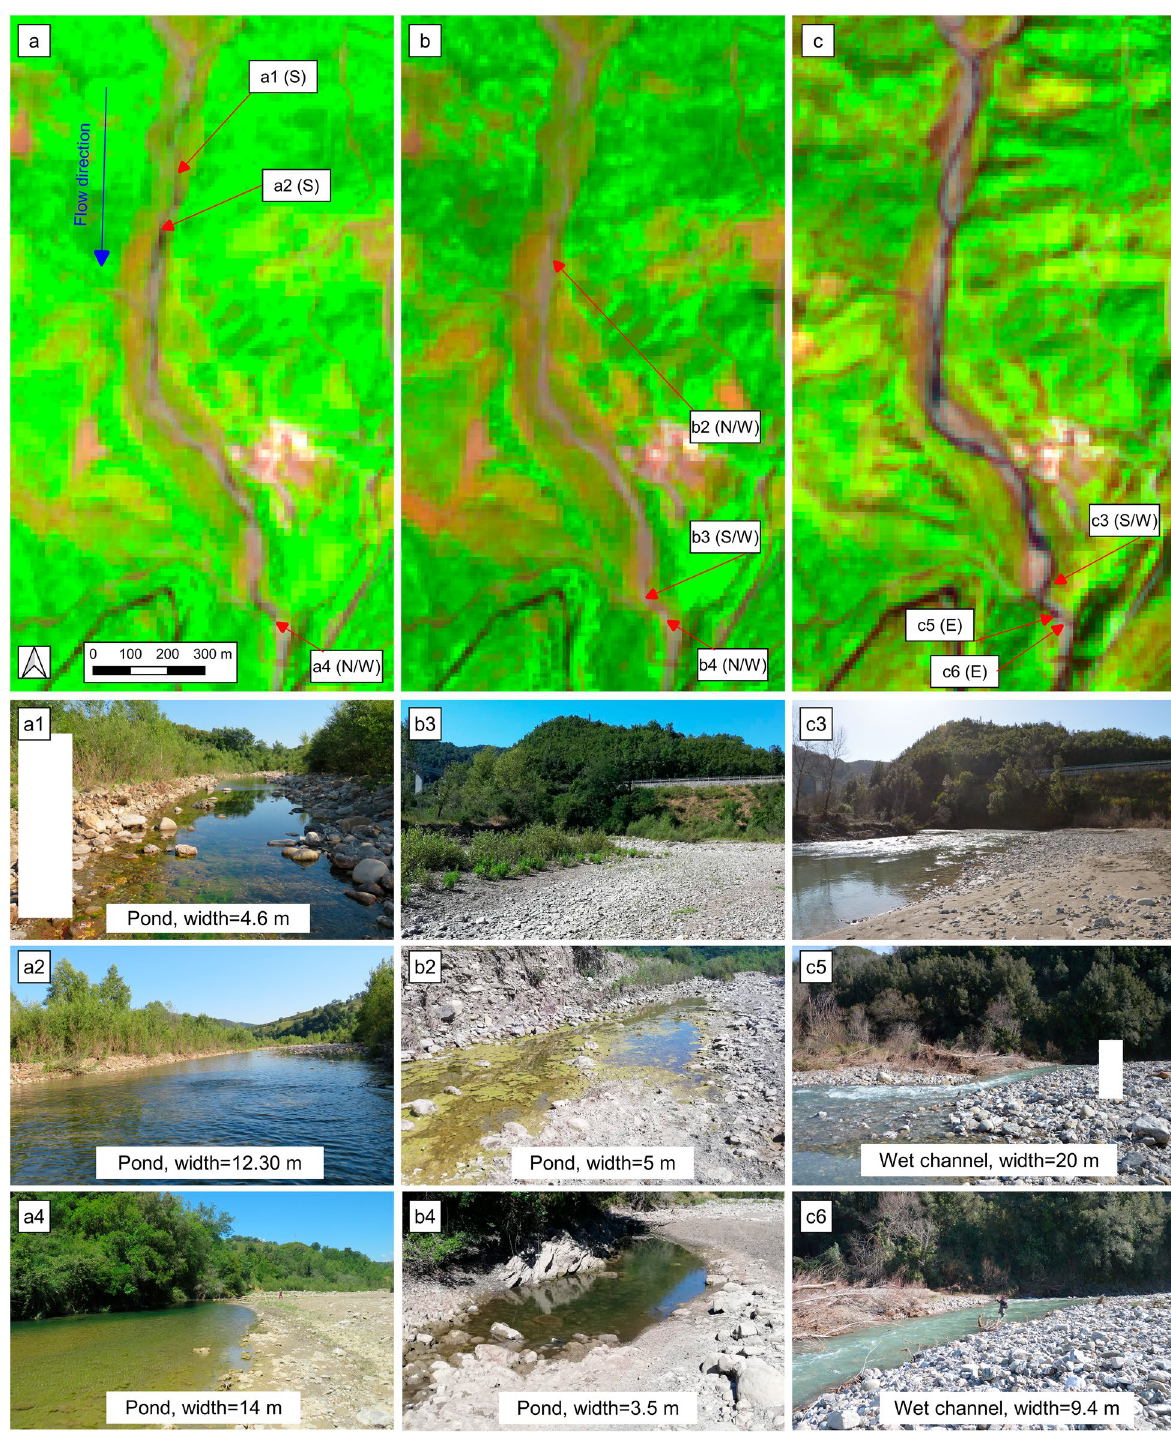
Figure 6. Test cases 2, 3, 5, S1 reach, ( a ) FCI of 26 June 2020, ( b ) FCI of 26 July 2020, ( c ) FCI of 6 February 2021, (a1,a2 and a4) photos taken on 26 June 2020, (b3,b2 and b4) photos taken on 26 July 2020, and (c3,c5 and c6) photos taken on 6 February 2021. Photo-taking orientation are reported in brackets in the labels of a, b and c panels. Note: White boxes are used to cover people incidentally taken from the photos. QGIS 3.10.11 https:// www. qgis. org/ it/ site/ forus ers/ downl oad.